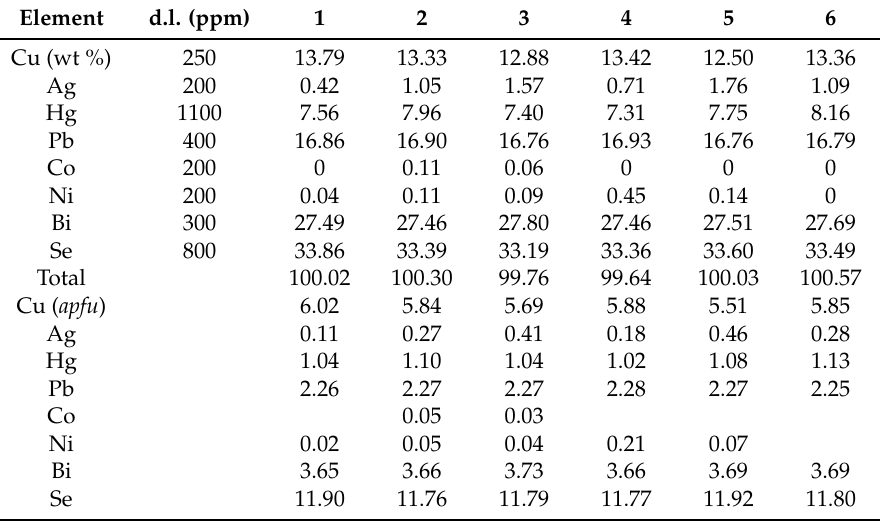
Table 3. Representative results of electron-microprobe spot analyses of quijarroite.